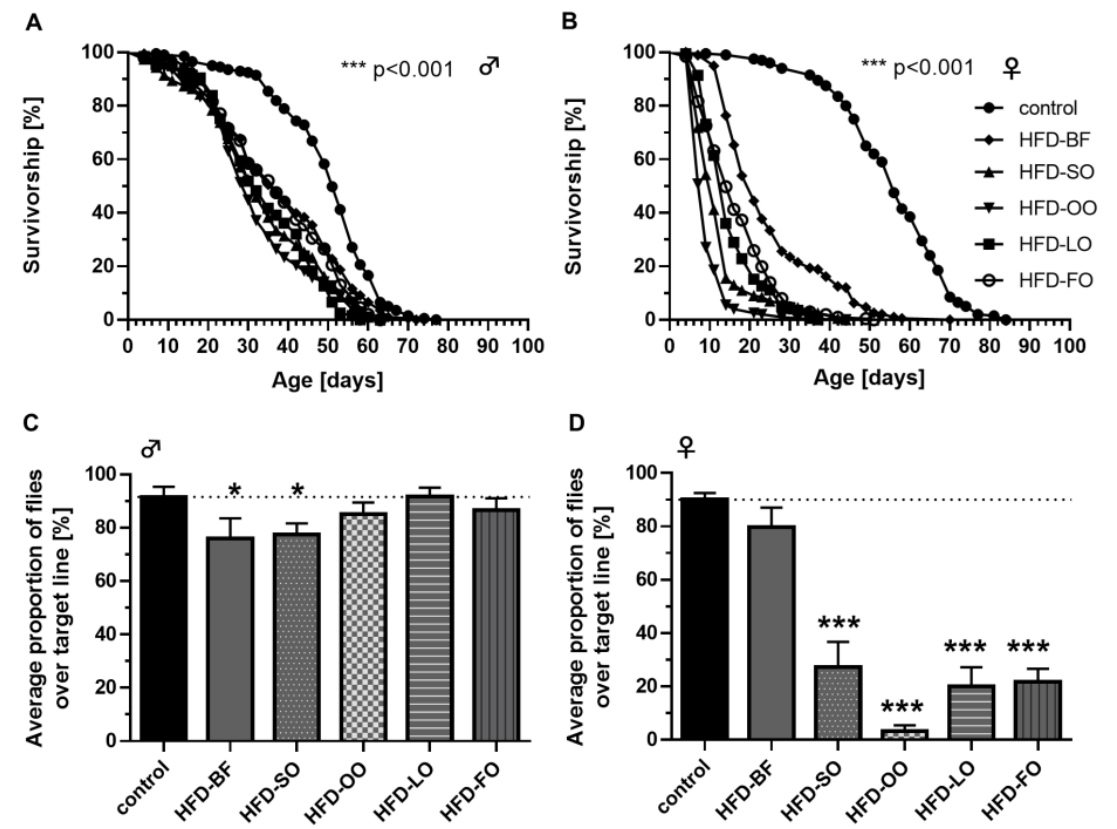
Figure 9. The impact of different high-fat diet (HFD) qualities on the lifespan and climbing activity of D. melanogaster. Lifelong ingestion of an HFD comprising either 12% ( w / v ) butterfat (BF), sun- flower oil (SO), olive oil (OO), linseed oil (LO) or fish oil (FO) significantly reduced the lifespan of ( A ) male and ( B ) female D. melanogaster compared to controls. D. melanogaster w 1118 flies were fed ad